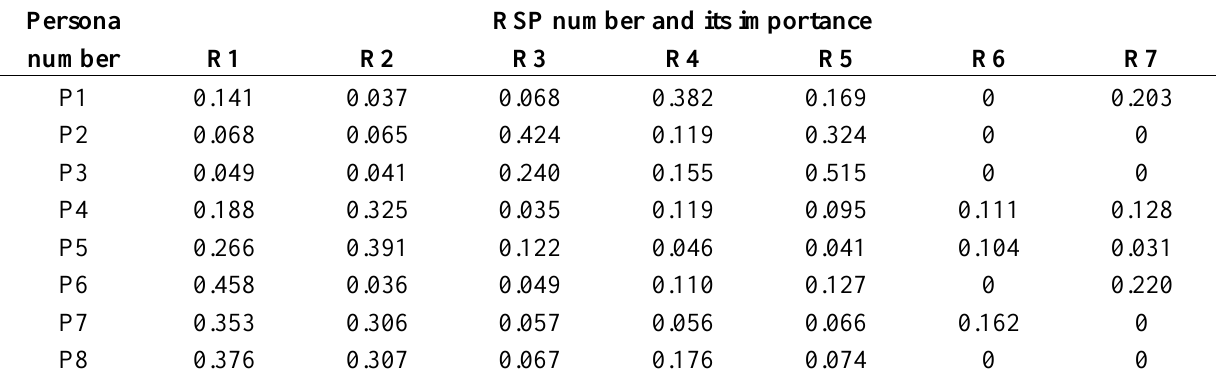
Table 4. Importance of the RSPs for each